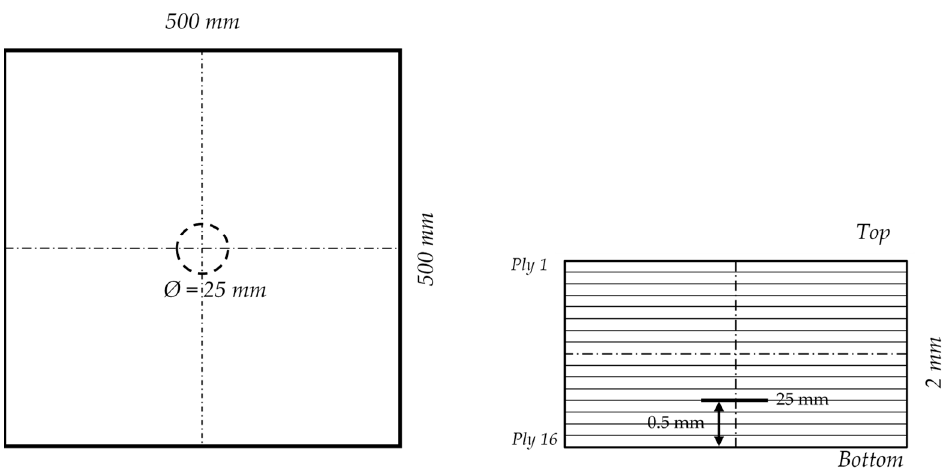
Figure 2. Schematic of the 2-mm quasi-isotropic [ − 45/90/45/0] 2s carbon fiber-reinforced polymer (CFRP) composite plate with delamination simulated by the Teflon insert.